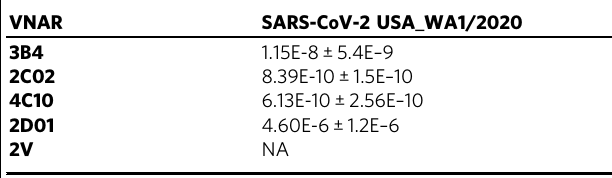
Table 1 VNAR IC 50 values for neutralization of